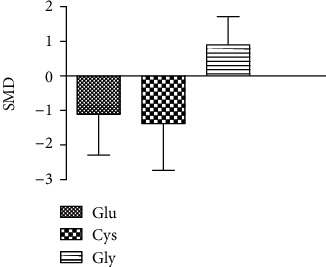
Meta-analysis of the effects of arsenic on Glu, Cys, and Gly in vivo. SMD; standardized mean difference. The P value of the Glu's overall effect test is 0.04. The P value of the Cys's overall effect test is 0.01. The P value of the Gly's overall effect test is 0.36. When P < 0.05, the difference was considered statistically significant.